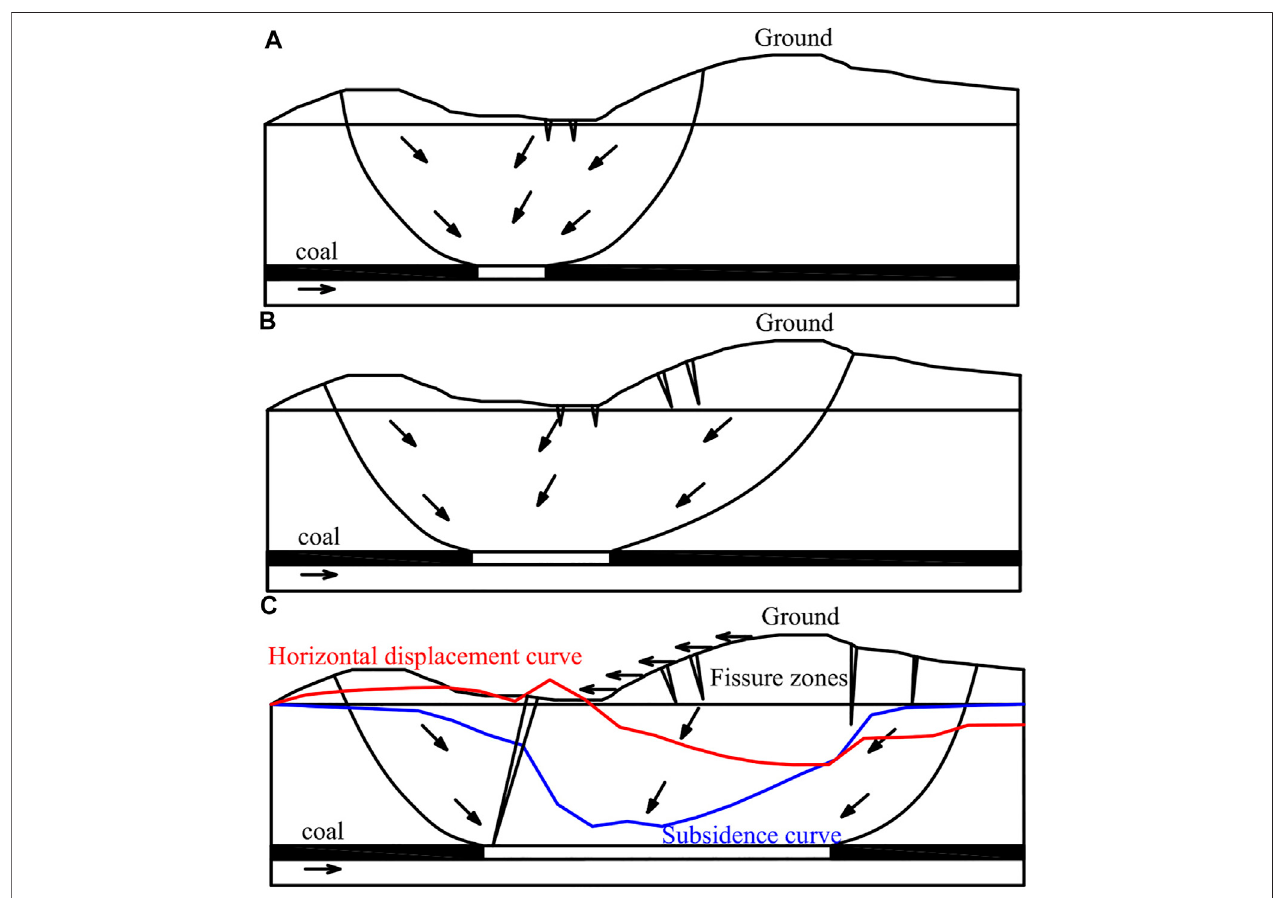
FIGURE 14 | Surface movement and deformation process in the loess gully area. (A) Tensile failure of the slope bottom. (B) Traction failure of the slope body. (C) Sliding failure of the slope top.